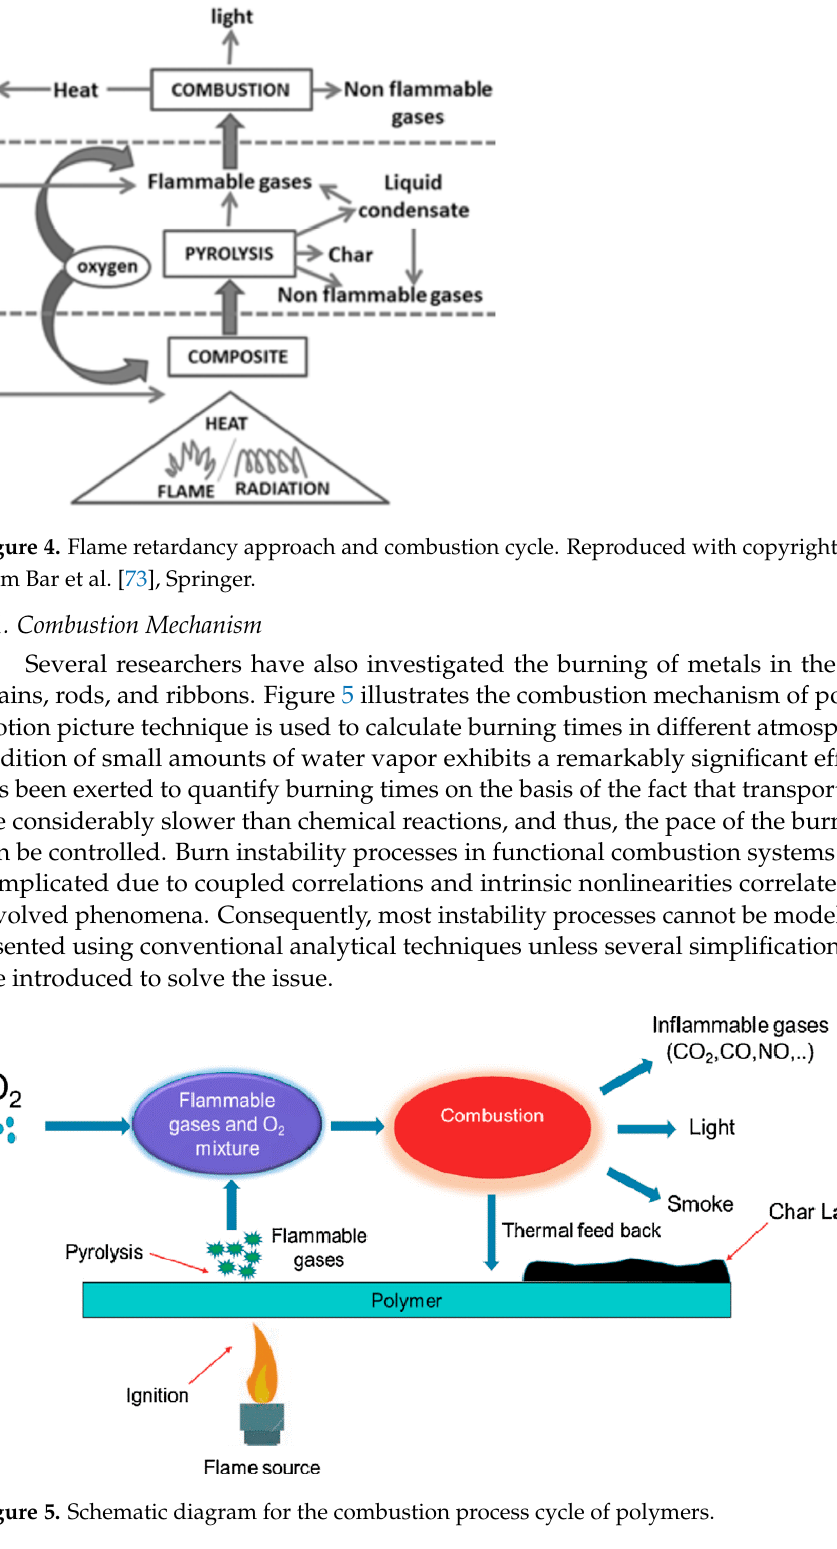
Figure 5. Schematic diagram for the combustion process cycle of polymers.